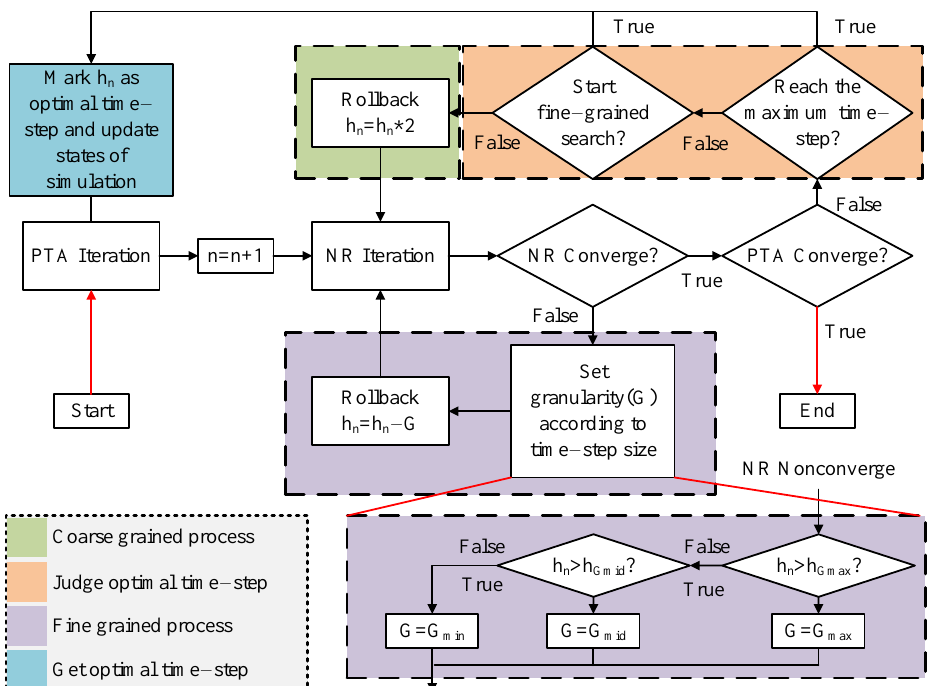
Figure 5. Hybrid searching strategy for finding the optimal time step. The symbol n indicates PTA iteration steps; h Gmid and h Gmax are threshold values for judging granularity(G); and Gmid , Gmin , and Gmax represent different granularity for sampling